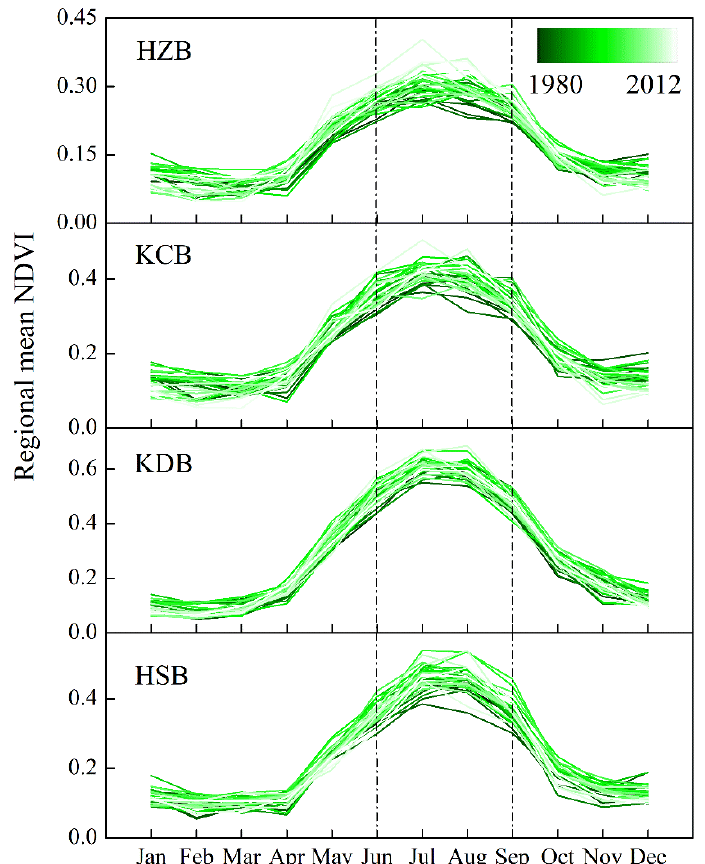
Figure 3. Phenological curve of the four basins based on regional mean NDVI from 1980 to 2012. Dashed lines indicate that vegetation of the four basins complete the “green up” processes in June and start to wither after September.